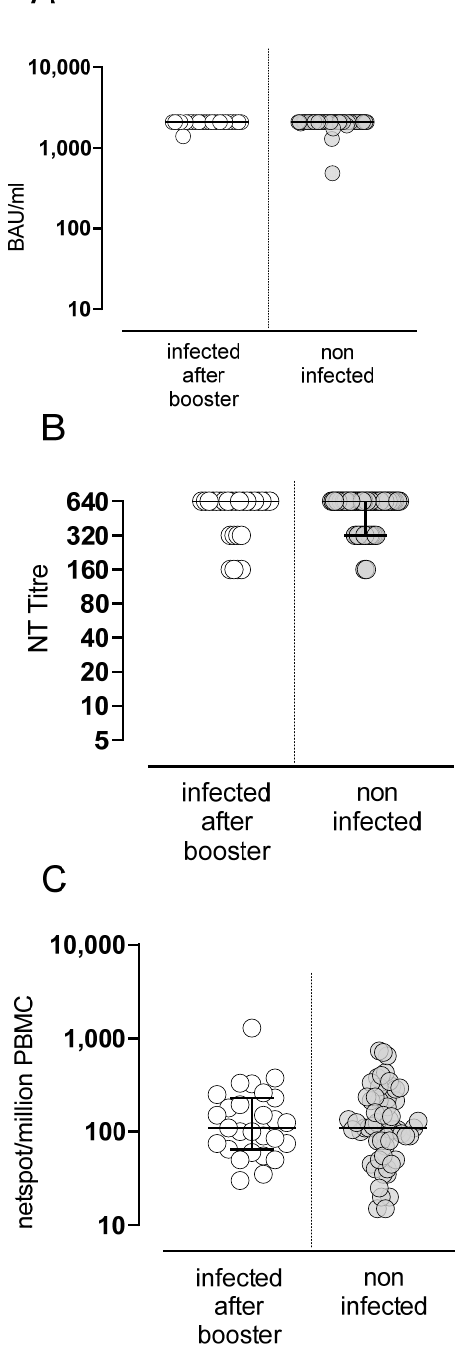
Figure 5. Spike-specific B and T-cell responses in SARS-CoV2 infection in vaccinated subjects. Levels of anti-spike IgG antibodies ( A ), NT Abs ( B ) and Spike-specific T-cell response ( C